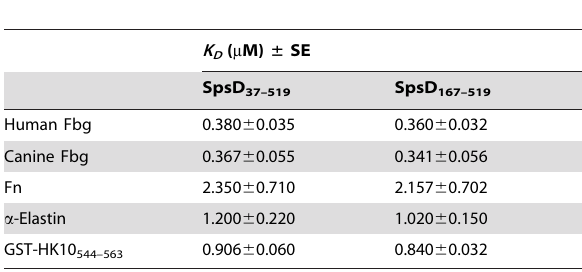
Table 1. Summary of K D 6 SE values of SpsD proteins for extracellular matrix